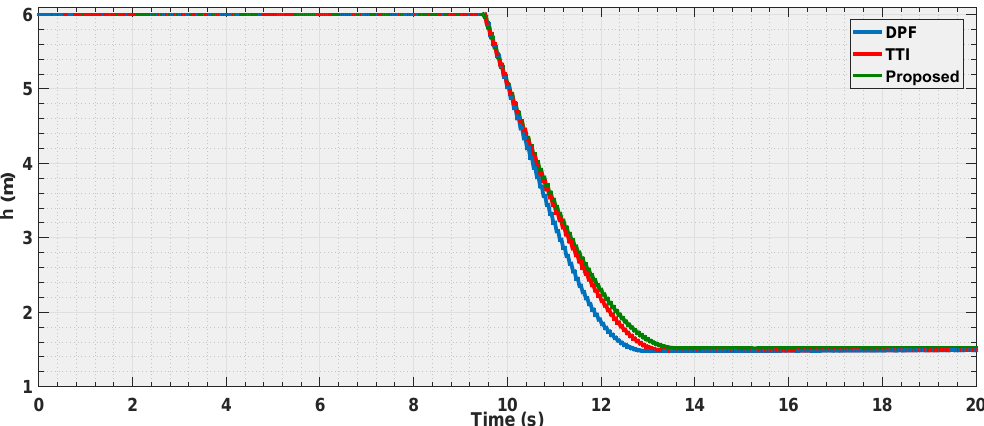
Figure 18. Distance estimation by the three evaluated algorithms Experiment 3